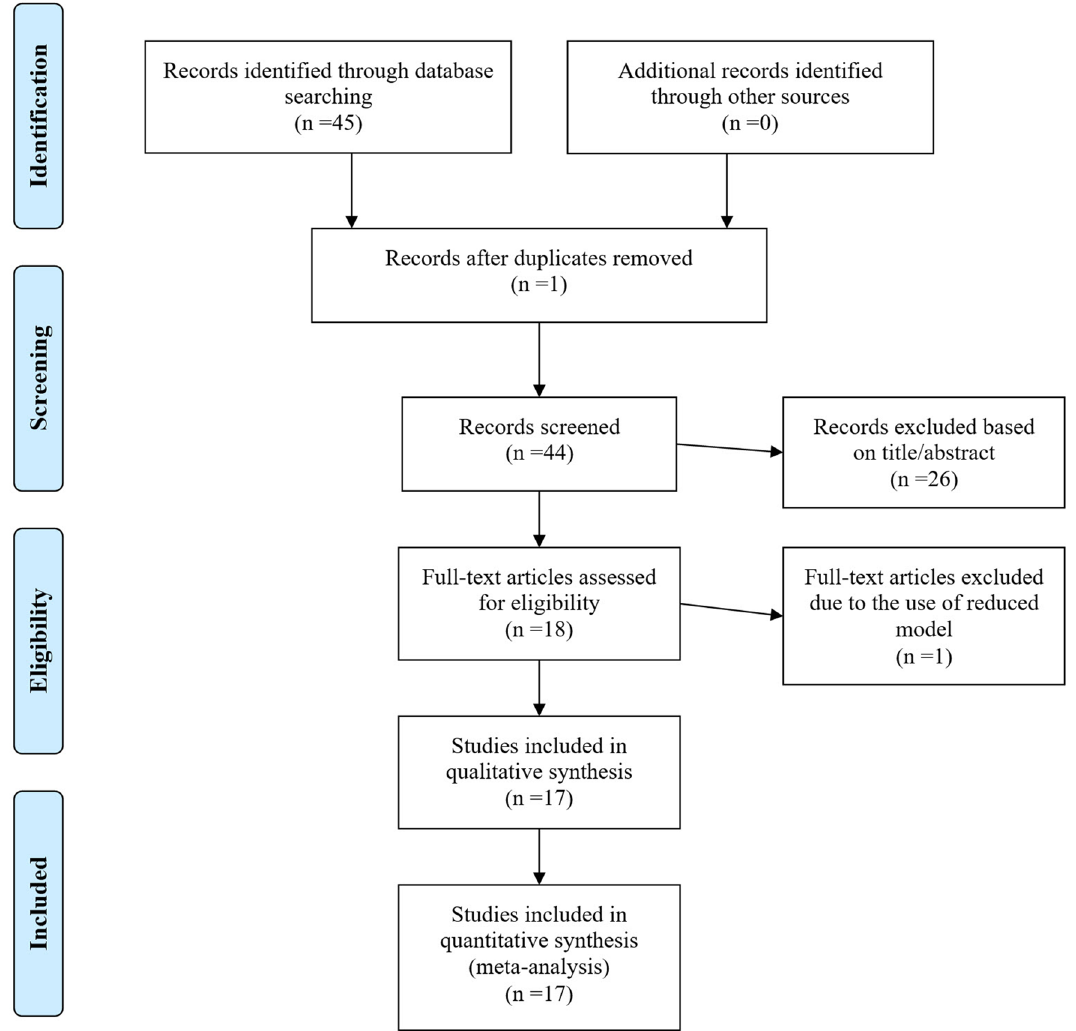
Figure 1. The PRISMA flowchart to describe the process of study selection and systematic literature